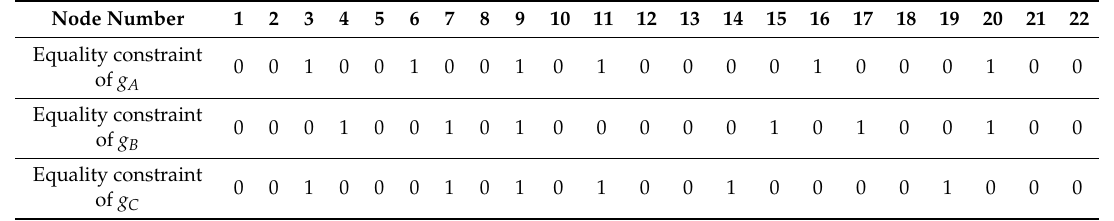
Table 4. Optimum placement of ATCTrs (solution B).